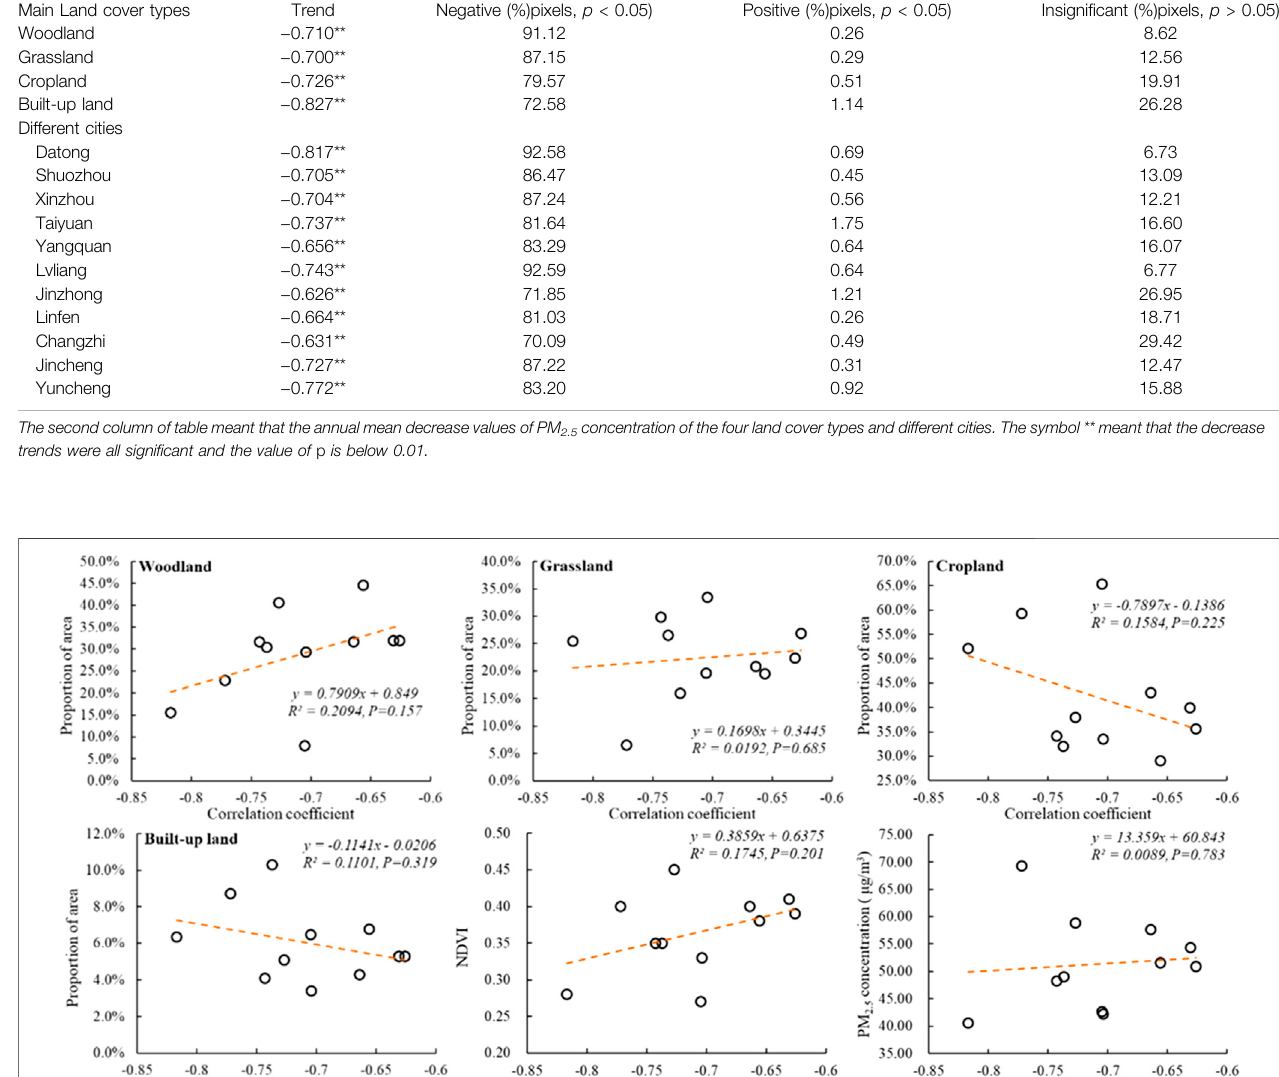
Correlation of PM 2.5 and NDVI